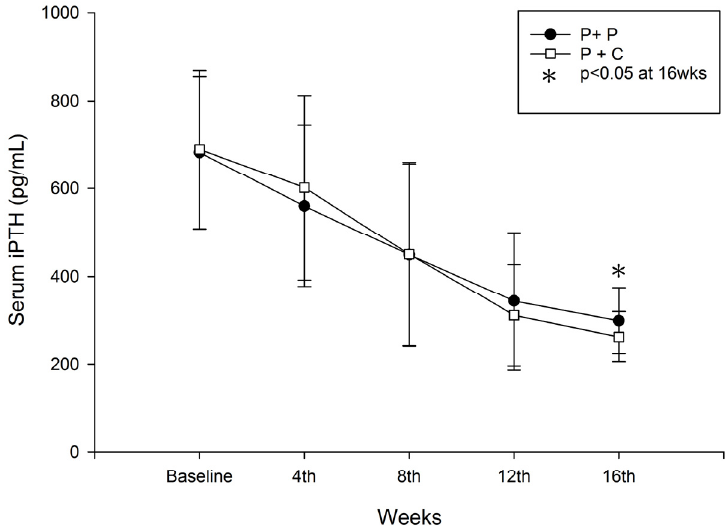
Figure 2. Changes in serum iPTH during the study period in both groups (P + P: paricalcitol plus